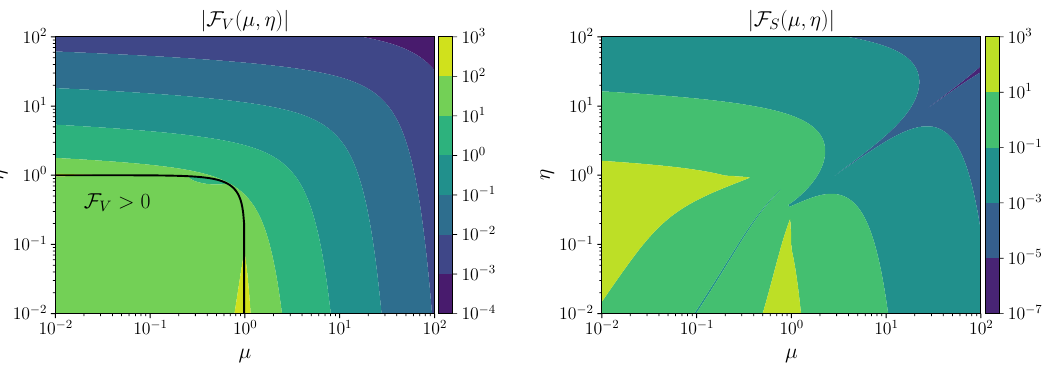
Figure 2. Absolute values of the functions F V ( µ, η ) (left) and F S ( µ, η )